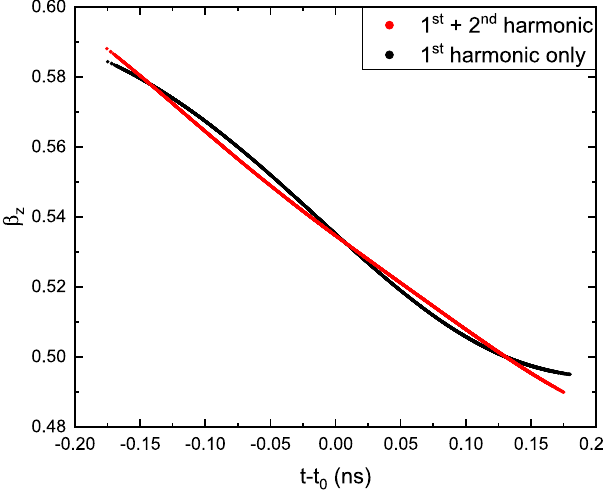
FIG. 8. GPT simulated longitudinal phase space ð t; β bunch directly behind the compression